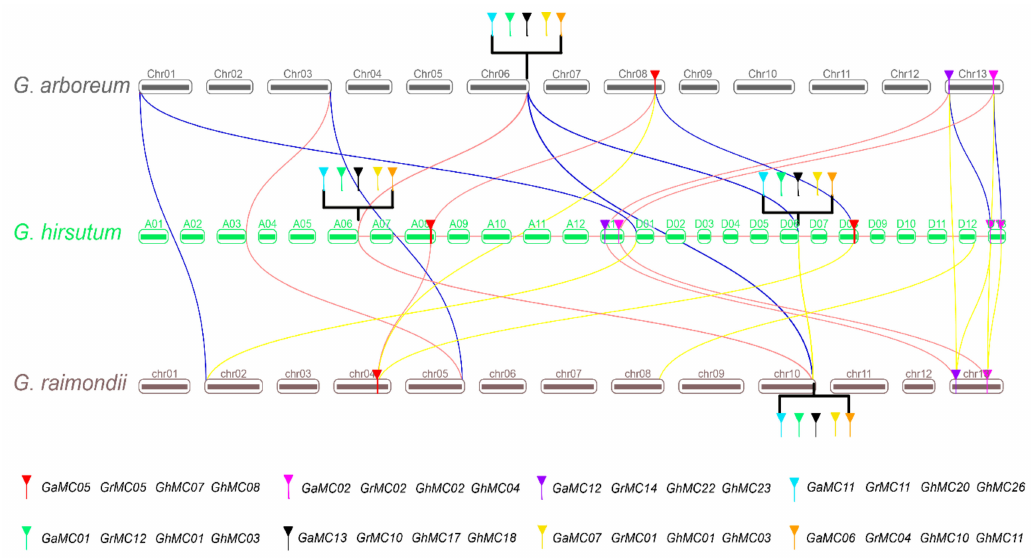
Figure 3. Collinearity of metacaspase genes in tetraploid and diploid cotton species.